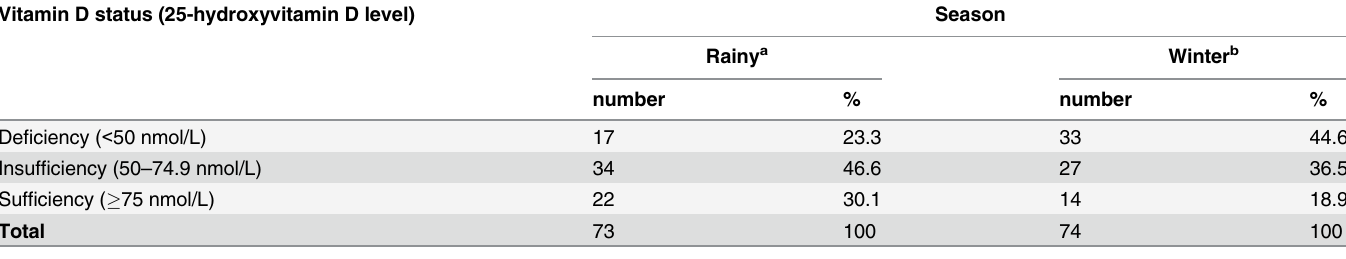
Table 1. Proportion of pregnancy with vitamin D deficiency, insufficiency, and sufficiency according to season (n = 147). Vitamin D status (25-hydroxyvitamin D